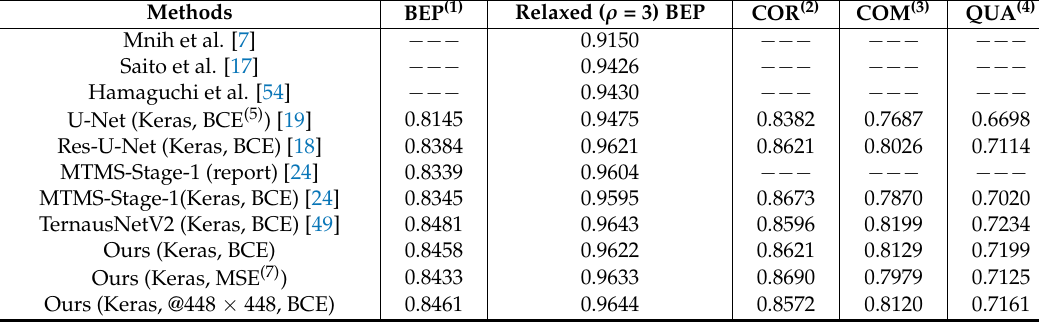
building extraction in shaded environments. In the 6th row, the U-Net model did not extract large-scale buildings well. The Res-U-Net model performed well on the building boundary but poorly in the central area of the building. Due to the size of the model’s receptive fields, there was a discontinuity